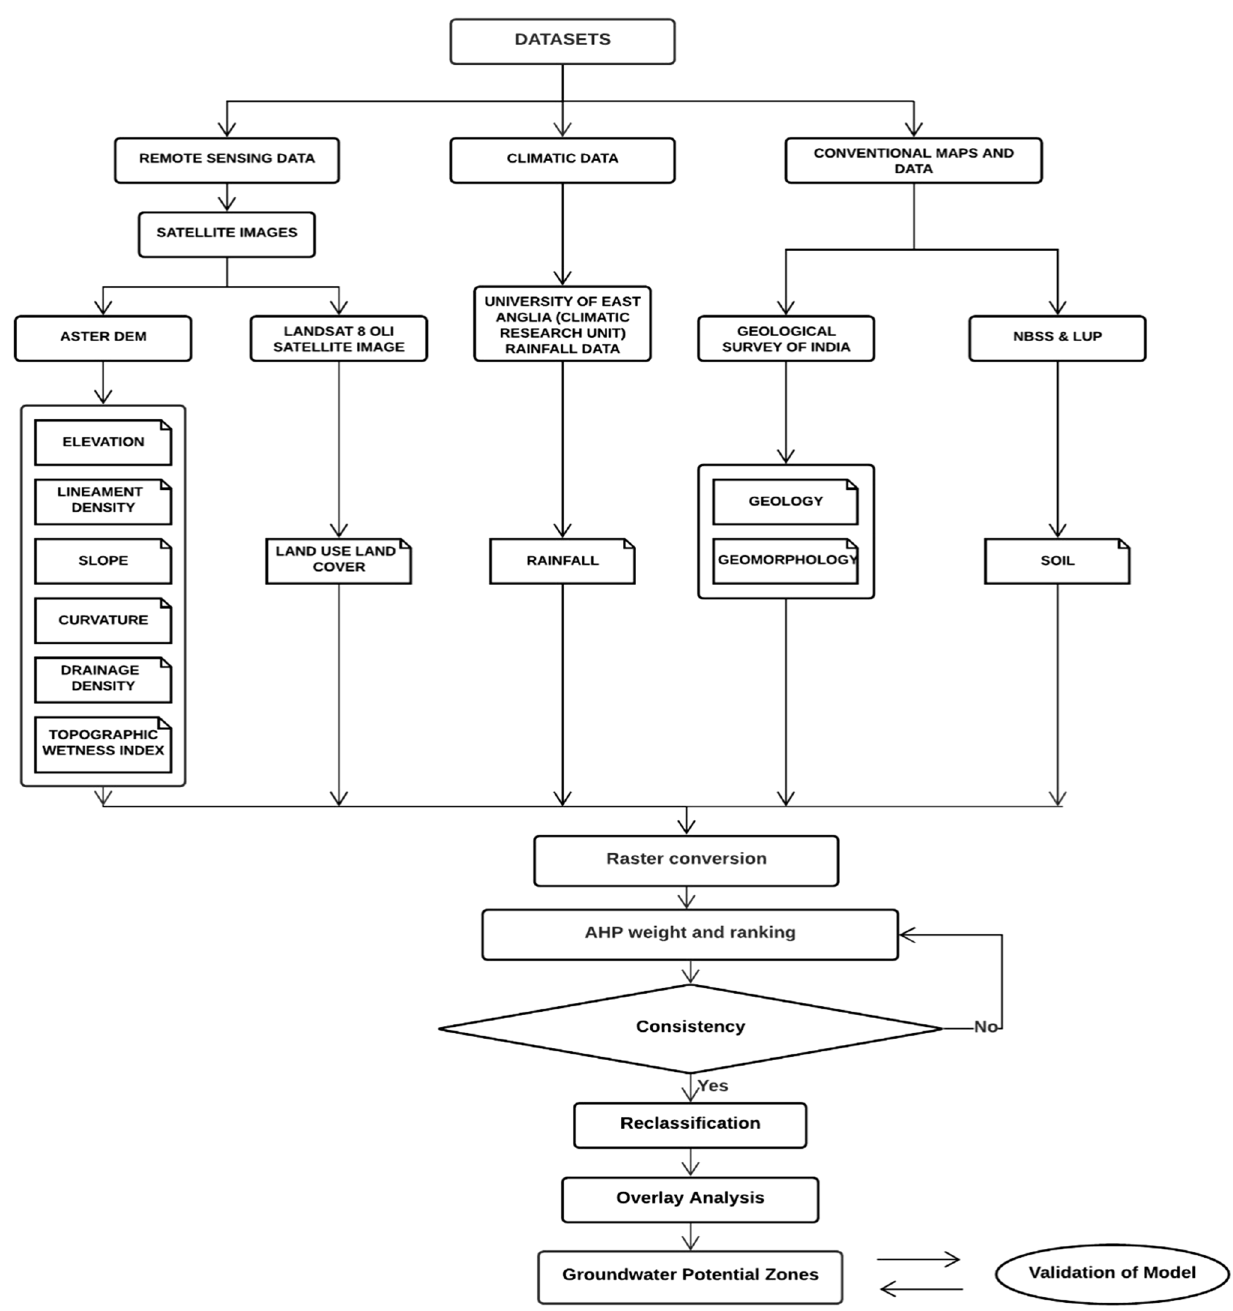
Fig. 2 Methodological flow-chart used in this study for groundwater potential zone